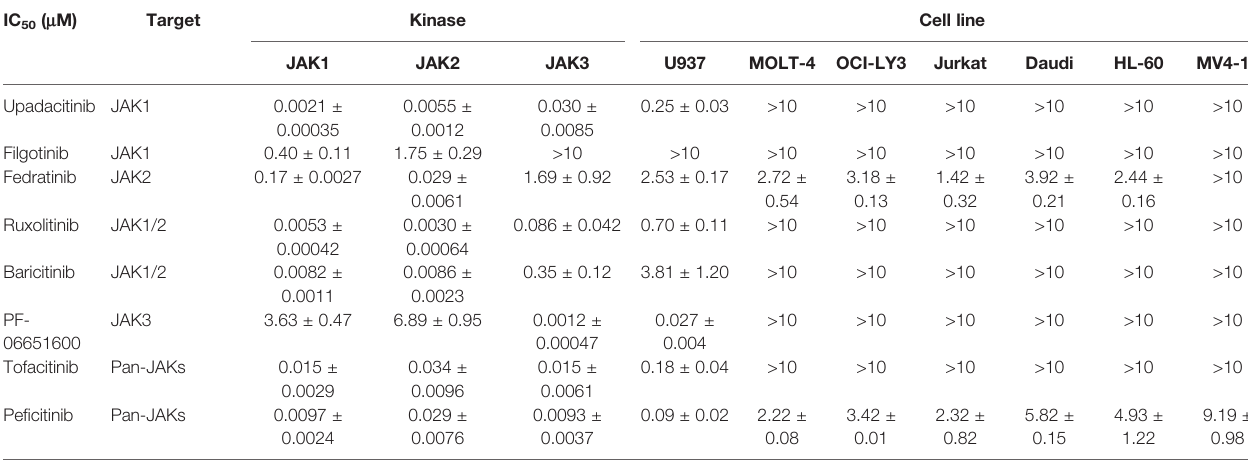
TABLE 1 | Kinase assay and anti-proliferative activities of JAK3 inhibitors. IC 50 ( m